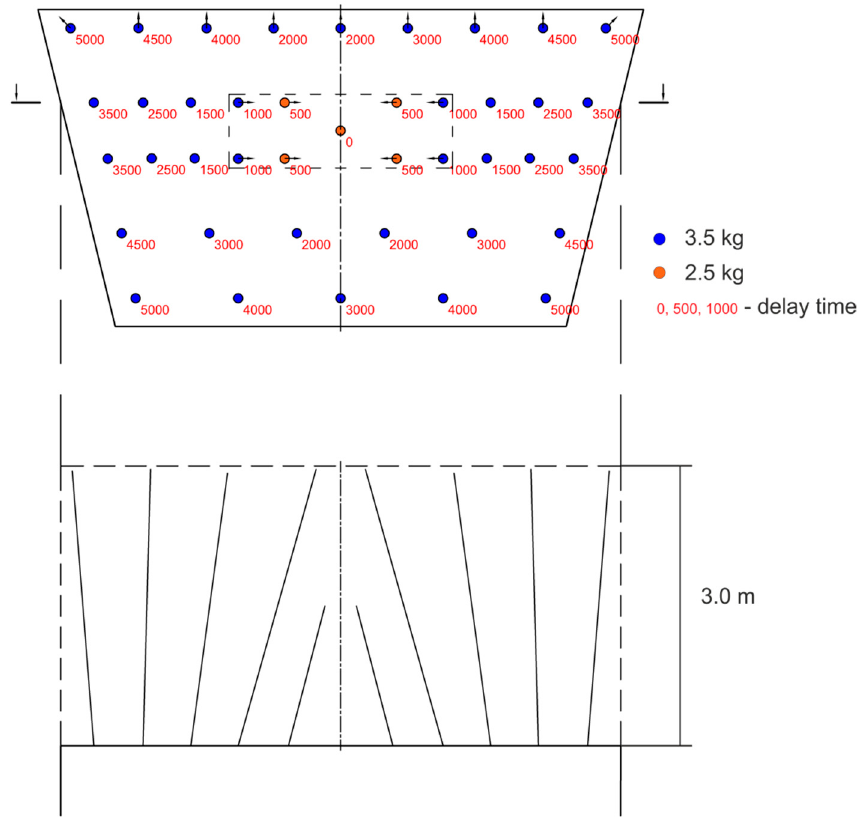
Figure 2. Drilling and blasting pattern used during underground trials: cross-section of the face ( upper ), topside view of the drilled blastholes ( lower ).